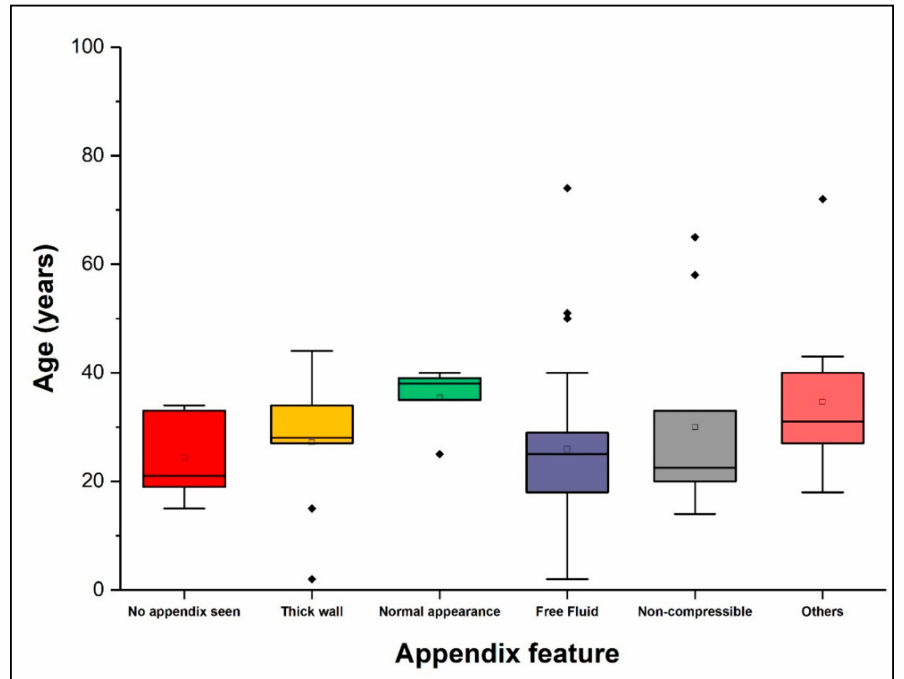
Figure 3. Boxplot illustrating the relationship between patients’ age and image features. The black dots represent data